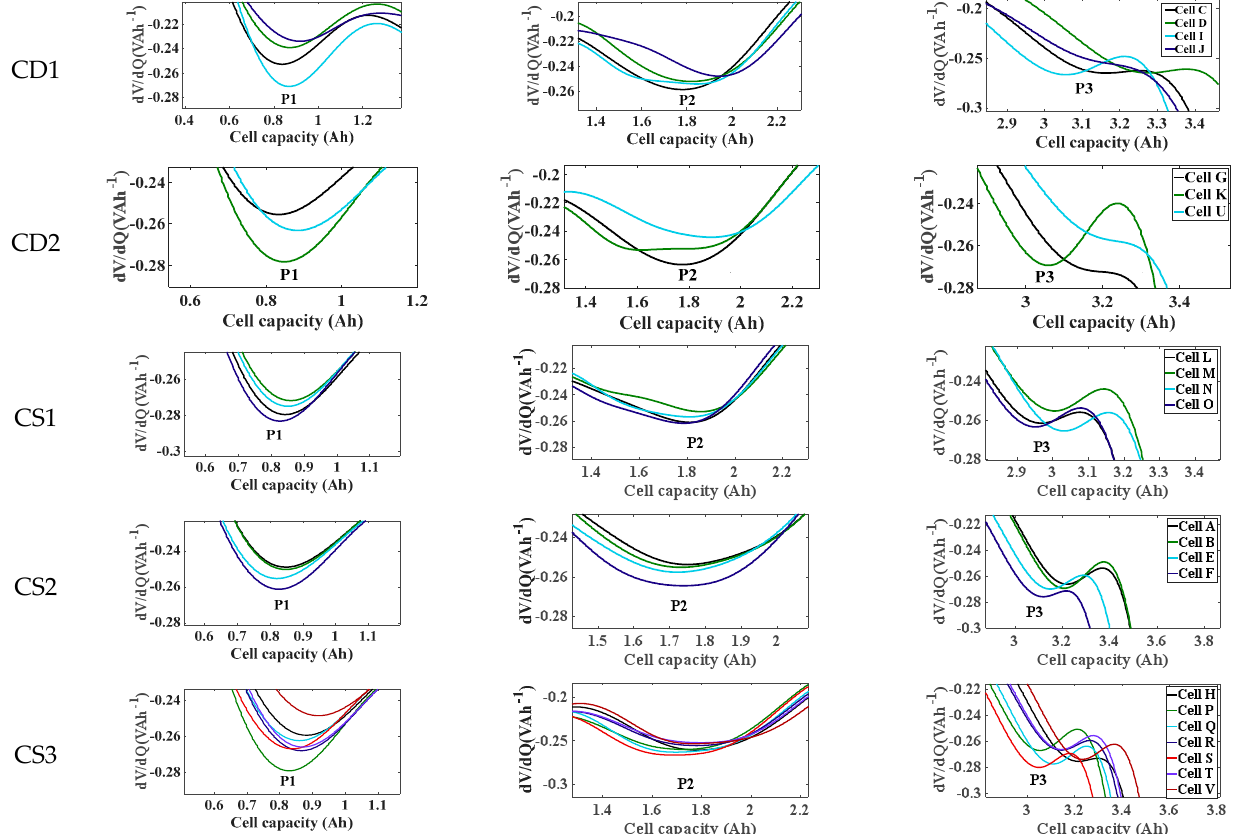
Figure 9. Magnified view of the DV curves .